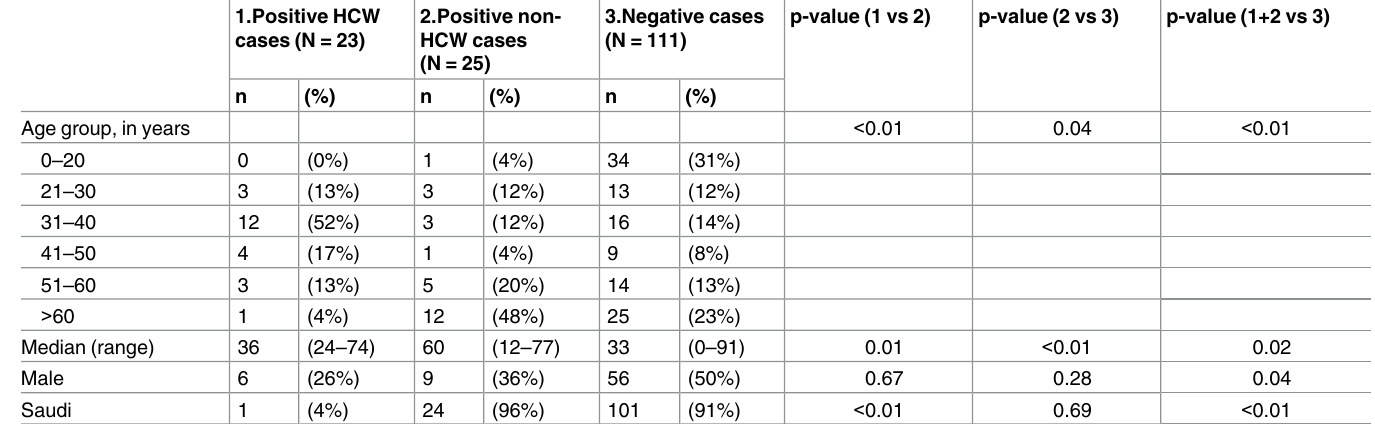
Table 1. Demographics of MERS positive HCW, MERS positive non-HCW and MERS negative cases.